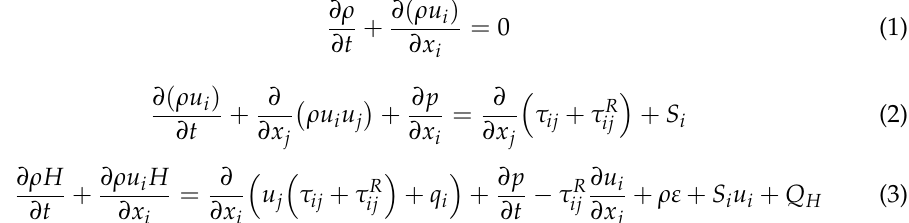
Thermal Conductivity [W/(mK)]